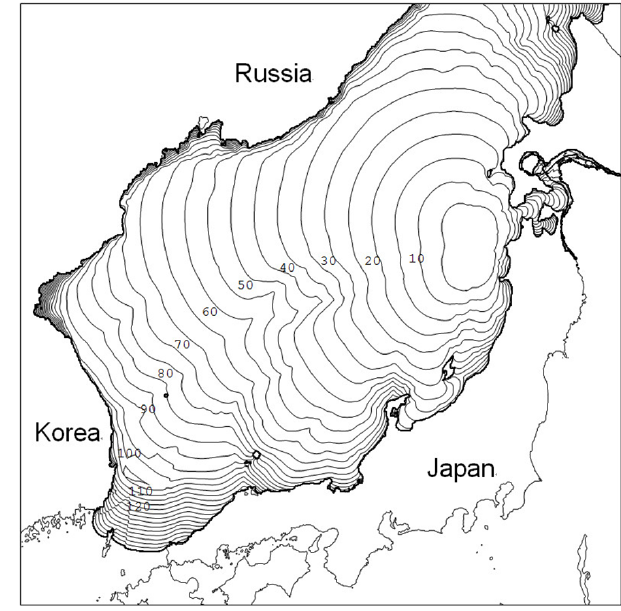
Figure 1. Locations of ports and earthquake sources for three major historical tsunamis.